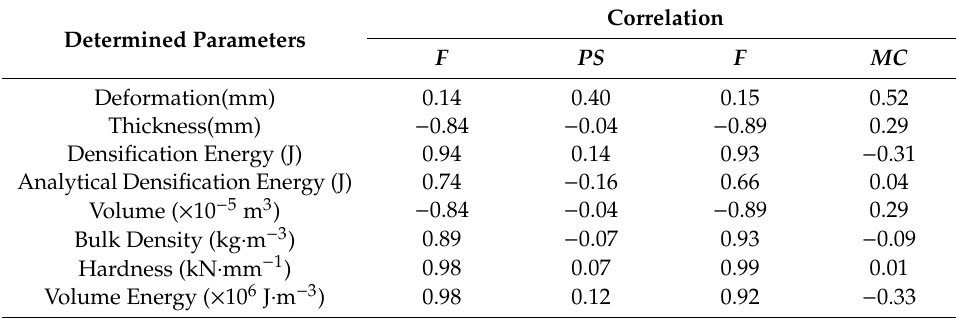
Table 4. Correlation results of the determined parameters against force, particle size, and moisture content of ground sunflower stalk